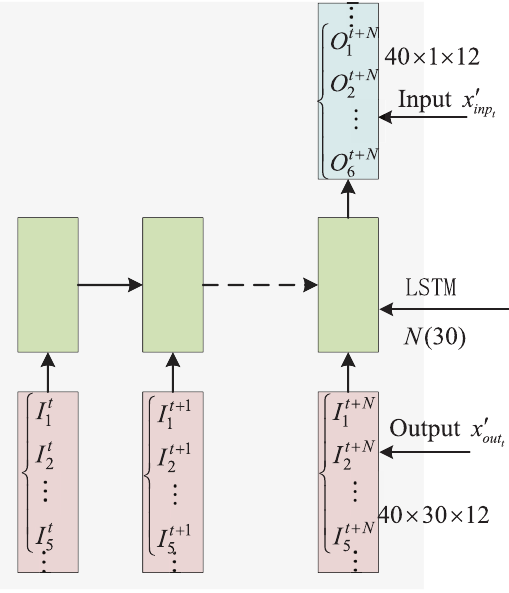
Figure 3. One-step AUV dynamic model based on